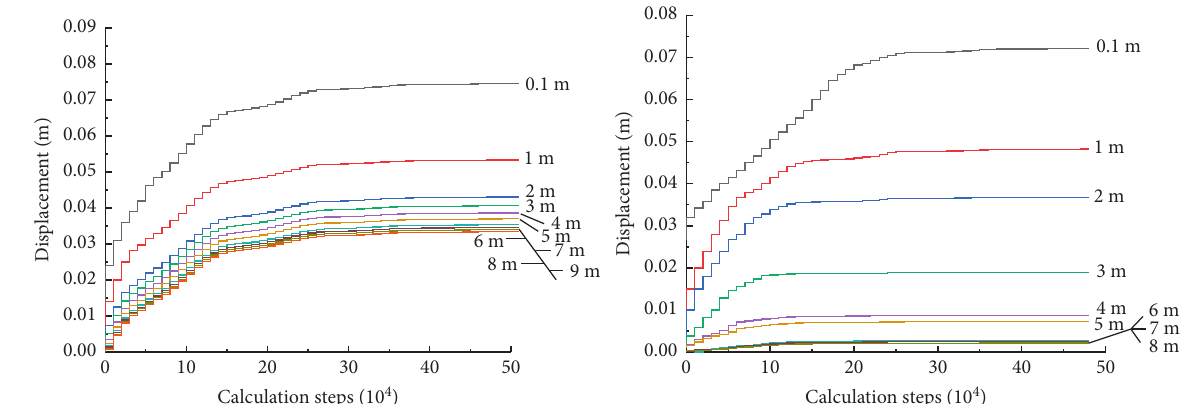
Figure 16: Simulated displacement evolution of the supported roadway.